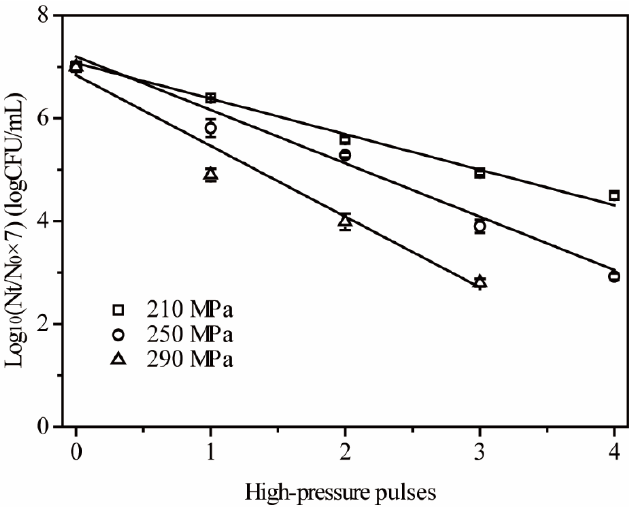
Figure 4. E. coli survivors in frozen carrot juice samples after multiple-pulse HP